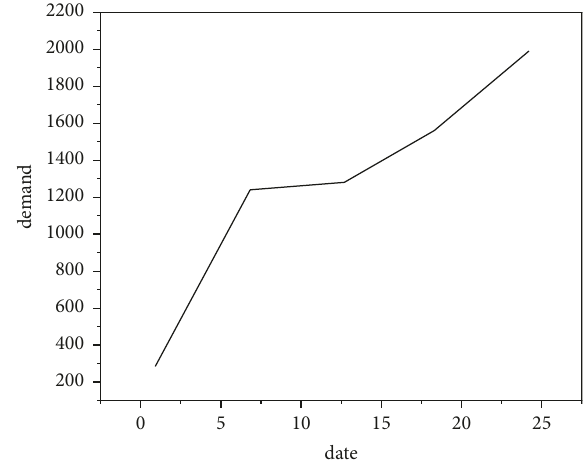
Figure 4: Overseas warehouse supply demand.